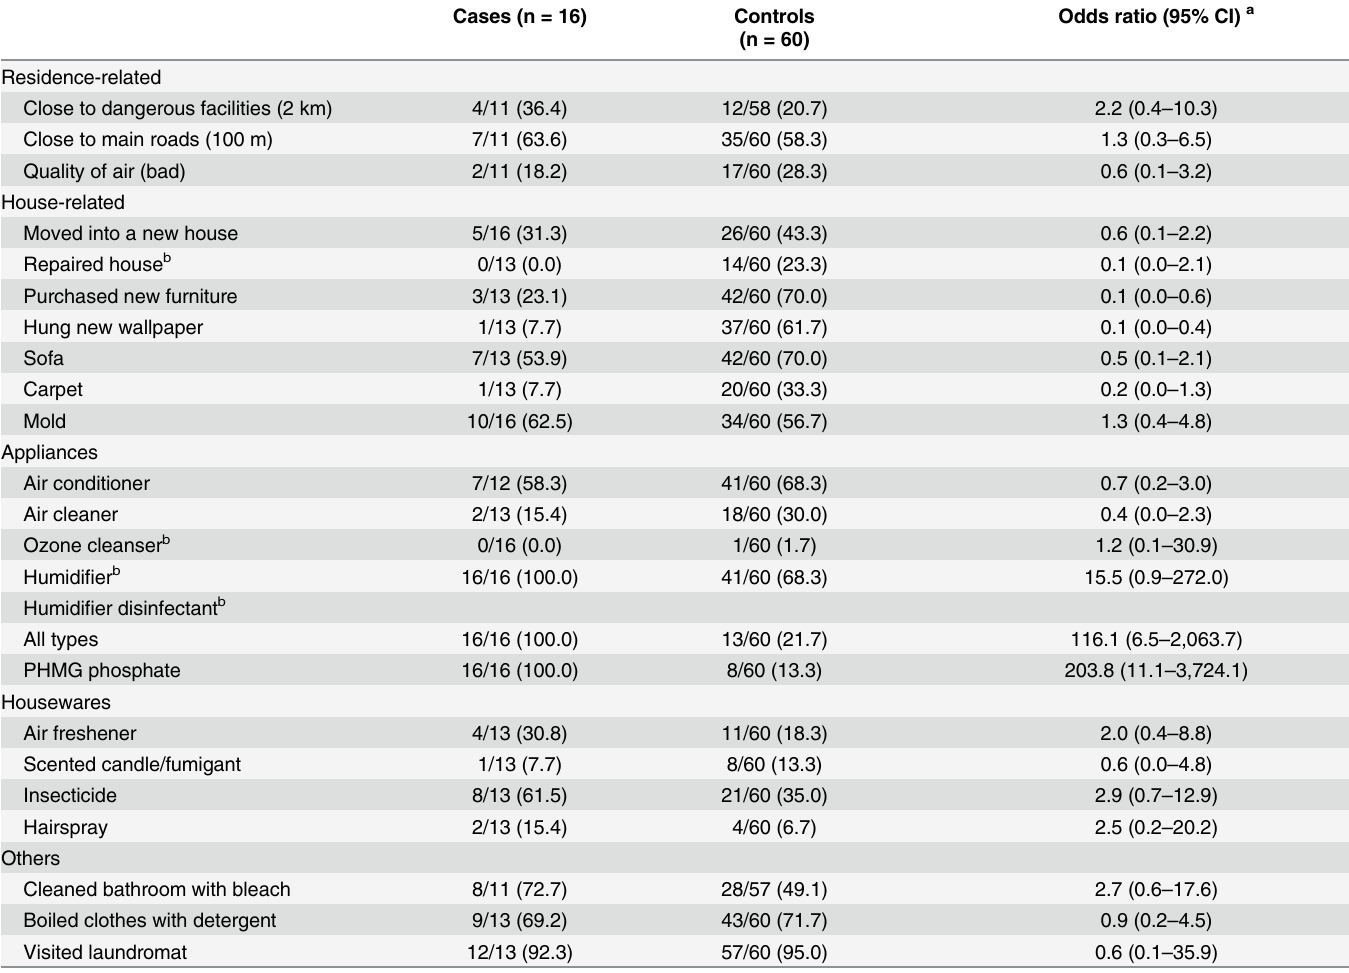
Table 2. Comparing the environmental exposures between the cases and